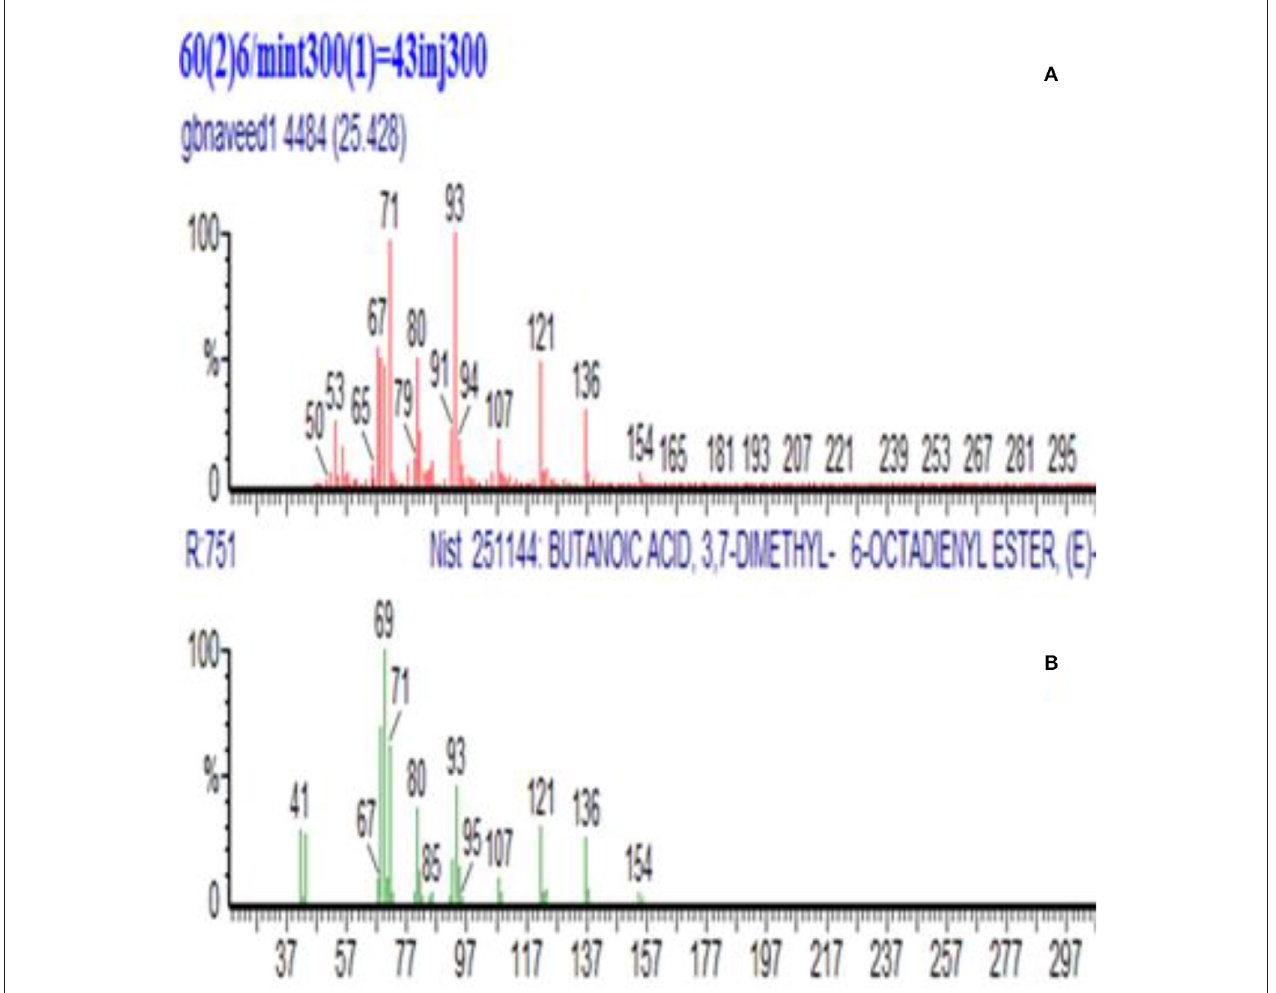
FIGURE 5 | GC-MS spectra of partially purified geranyl butyrate peak (1Y) and its conformation in this study. (A) Synthesized geranyl butyrate. (B) GC-MS Library of geranyl